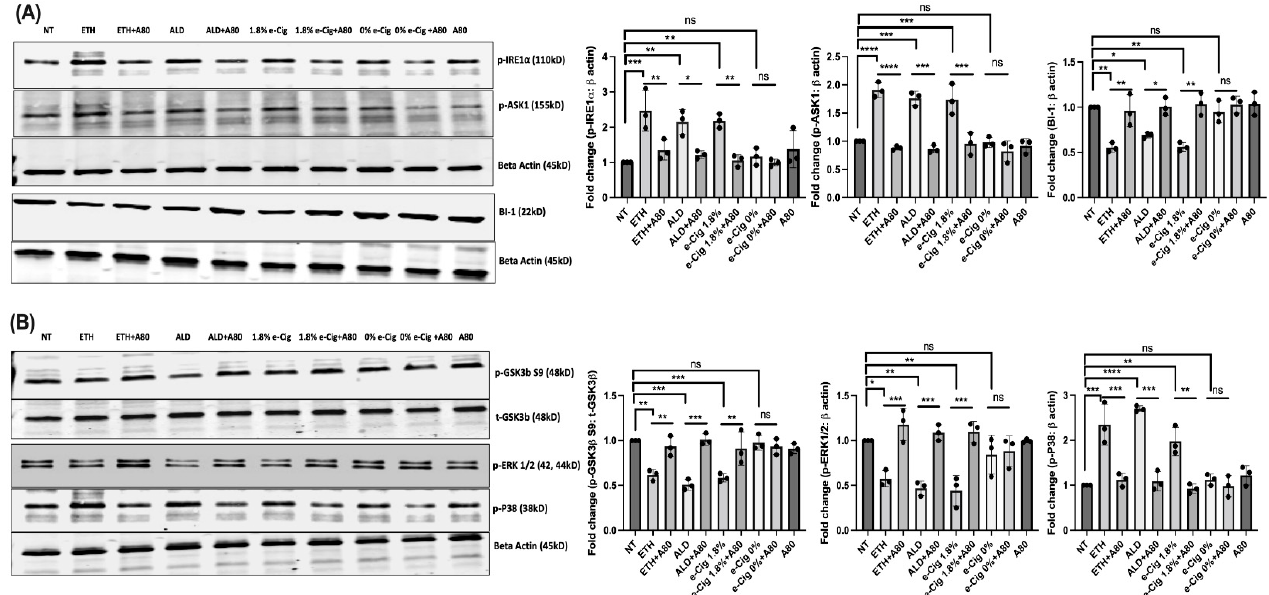
Figure 4. P2X7r antagonist (A804598) reduced the non-canonical ER stress induced by ETH, ALD, and e-Cig stimulation in hBMVECs. ( A ) ER Ca 2+ buildup induced by ETH, ALD, and 1.8% e-Cig stimulus increased the expression pro-apoptotic p-IRE1 α by three-fold and p-ASK1 by two-fold, respectively, and reduced the anti-apoptotic BAX inhibitor-1 (BI-1) protein expression by fifty percent (50%). ( B ) ER stress due to Ca 2+ accumulation also significantly reduced the expression of p-GSK3 β S9 and p-ERK1/2 and instigated p-P38 MAPK levels. hBMVECs treated with A804598 (A80) could prevent the ER stress induced apoptotic signals. Western blot data were normalized to β -actin/total GSK3 β ( n = 3). One-way ANOVA was used for the statistical analyses, marked as * p ≤ 0.05, ** p ≤ 0.01, *** p ≤ 0.001, **** p ≤ 0.0001 and ns (not significant).